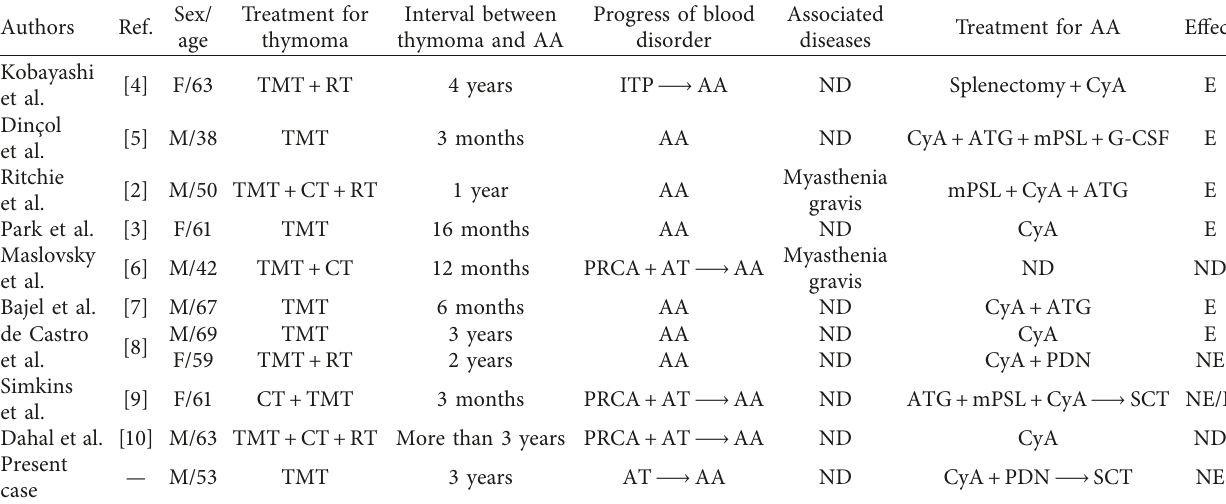
Table 1: Review of published cases of aplastic anemia after